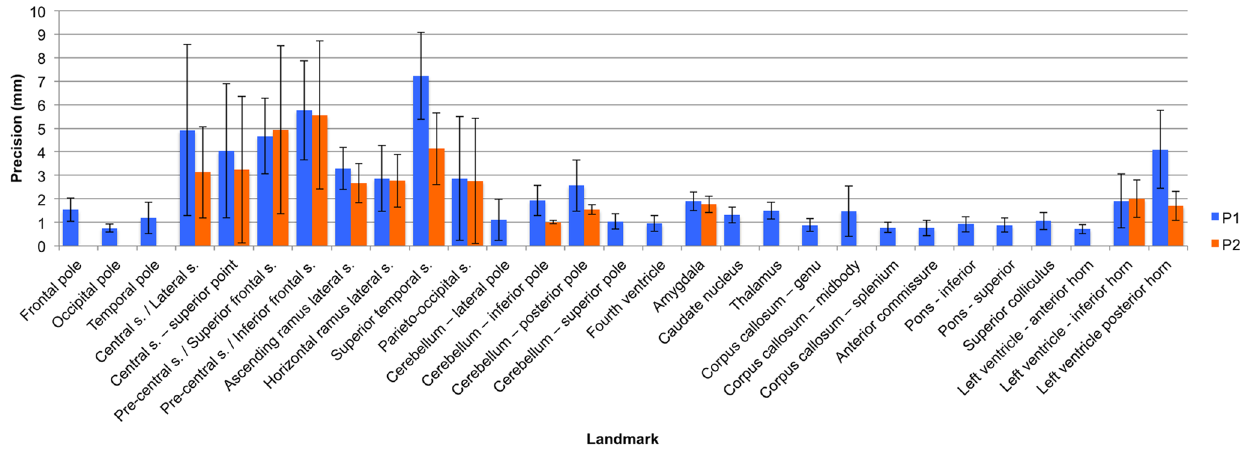
Figure 2. Histogram of the intra-observer precision of each landmark. This histogram indicates the level of intra-observer precision associated with each landmark using the original (P1) and modified (P2) protocols. The error bar is equal to one standard deviation above and below the mean. Landmark numbers correspond with the landmark numbers in Table 2.